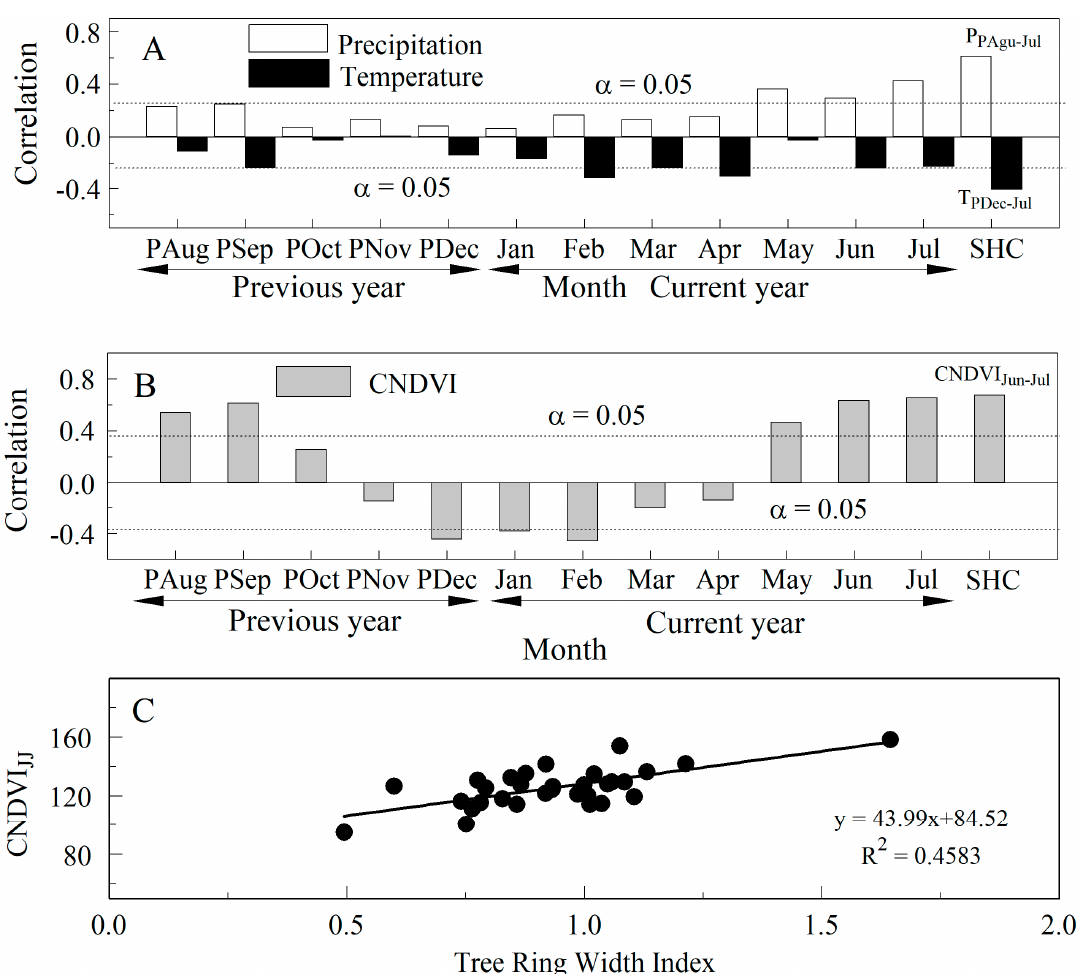
Figure 4. Correlations between the CW–DHM7 STD chronology and climatic factors: ( A ) with the regional precipitation and temperature of each month; ( B ) with the cumulative normalized difference vegetation index (CNDVI) of each month; ( C ) with CNDVI JJ during the period 1982–2013 CE. The CNDVI data from the Global Inventory Modeling and Mapping Studies (GIMMS) satellite datasets (119.34° E–120.07° E, 47.78° N–49.24° N, 1982–2013 CE); the averaged CNDVI in June to July ( CNDVI JJ ) is our reconstruction target. SHC in A and B indicates season with the highest correlation.